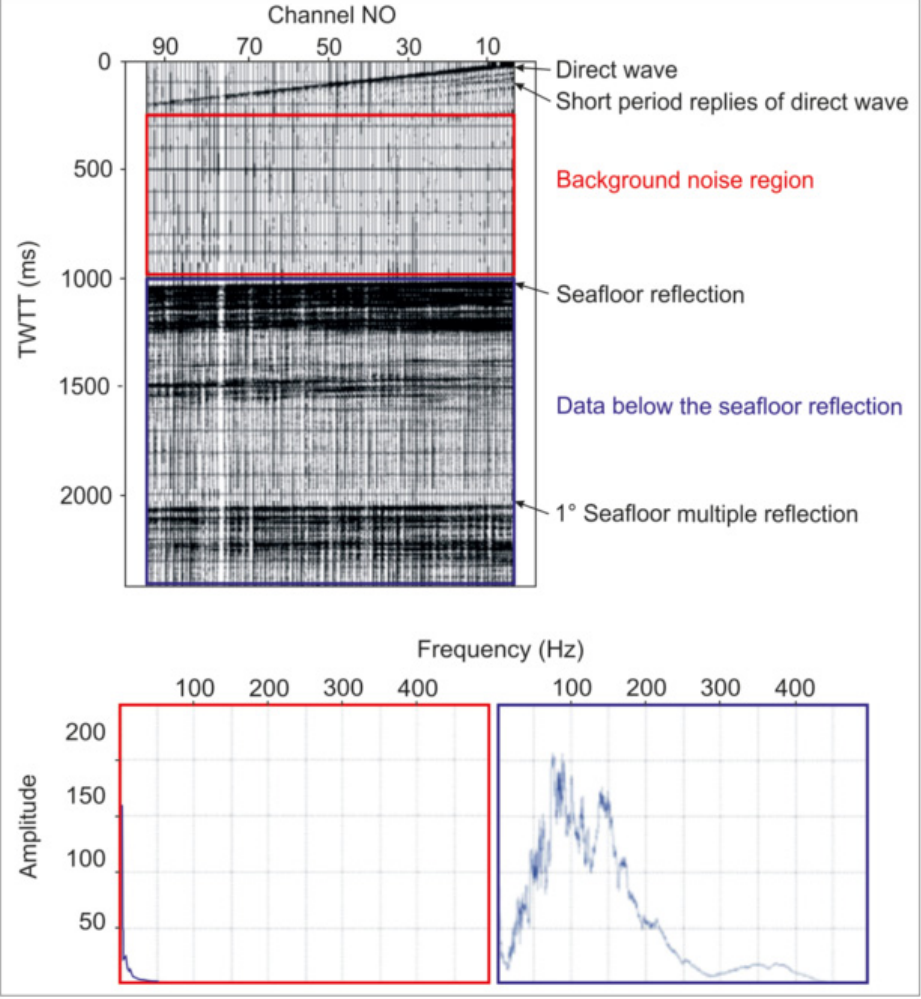
Figure 4. Example of raw data record (common-shot, on the top) of the line T_T05_HR, Tyrrhenian Sea). The main events are highlighted at the right side of the record. At the bottom: the background noise amplitude spectrum (red frame in the record) on the left and the reflected data region amplitude spectrum (blue frame in the record) on the